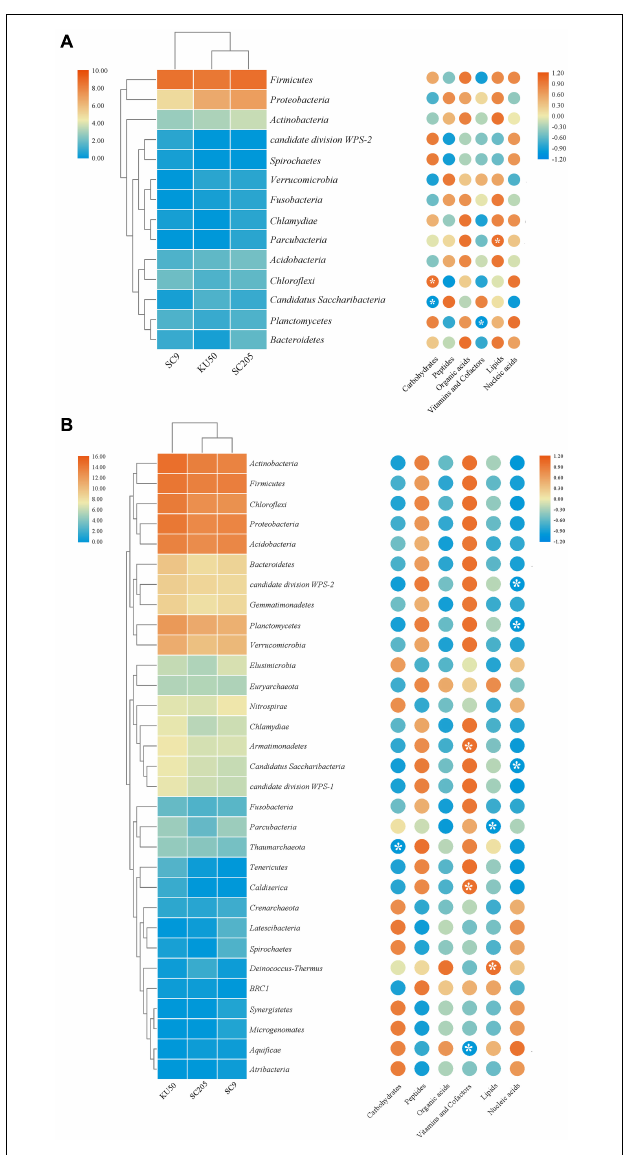
FIGURE 6 | Relative abundance of bacterial phyla detected in (A) tuber and (B) rhizosphere soil of three cassava genotypes, and correlation analysis of bacterial community compositions and metabolite components. *Indicates significant differences ( P <